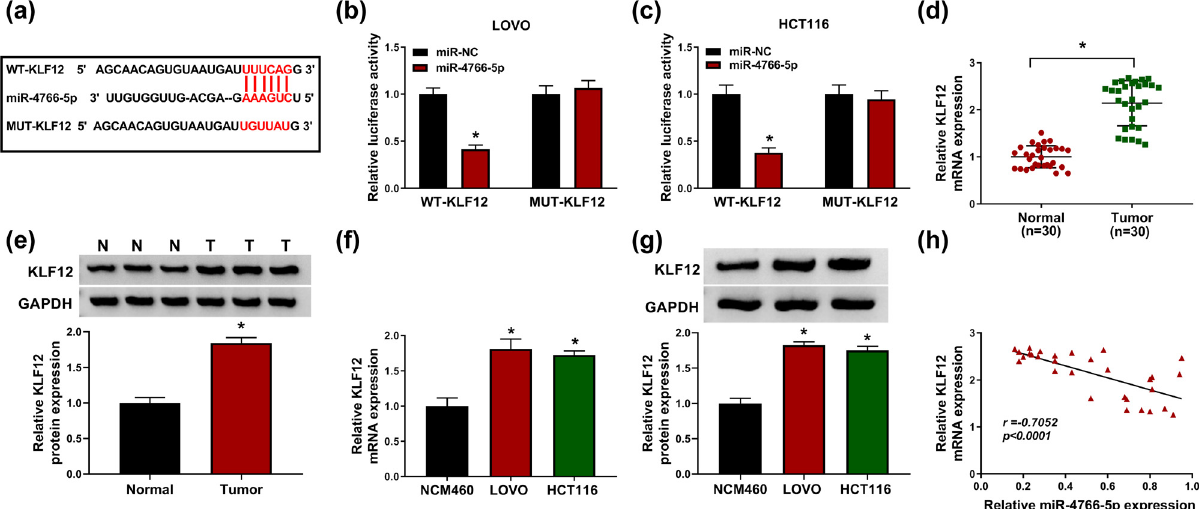
Figure 5: miR - 4766 - 5p targeted KLF12 in CRC cells. ( a ) The binding of miR - 4766 - 5p and KLF12 was predicted by Starbase. ( b and c ) Dual - determined by RT - qPCR and WB in CRC tissues ( d and e ) and cells ( f and g ) . ( h ) The correlation between miR - 4766 - 5p and KLF12